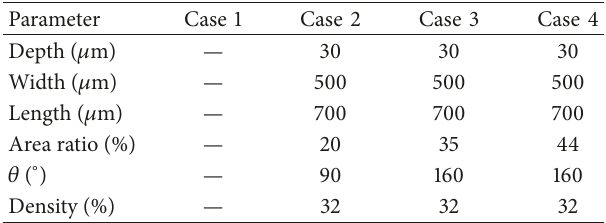
Table 2: Textures configurations on the bearing